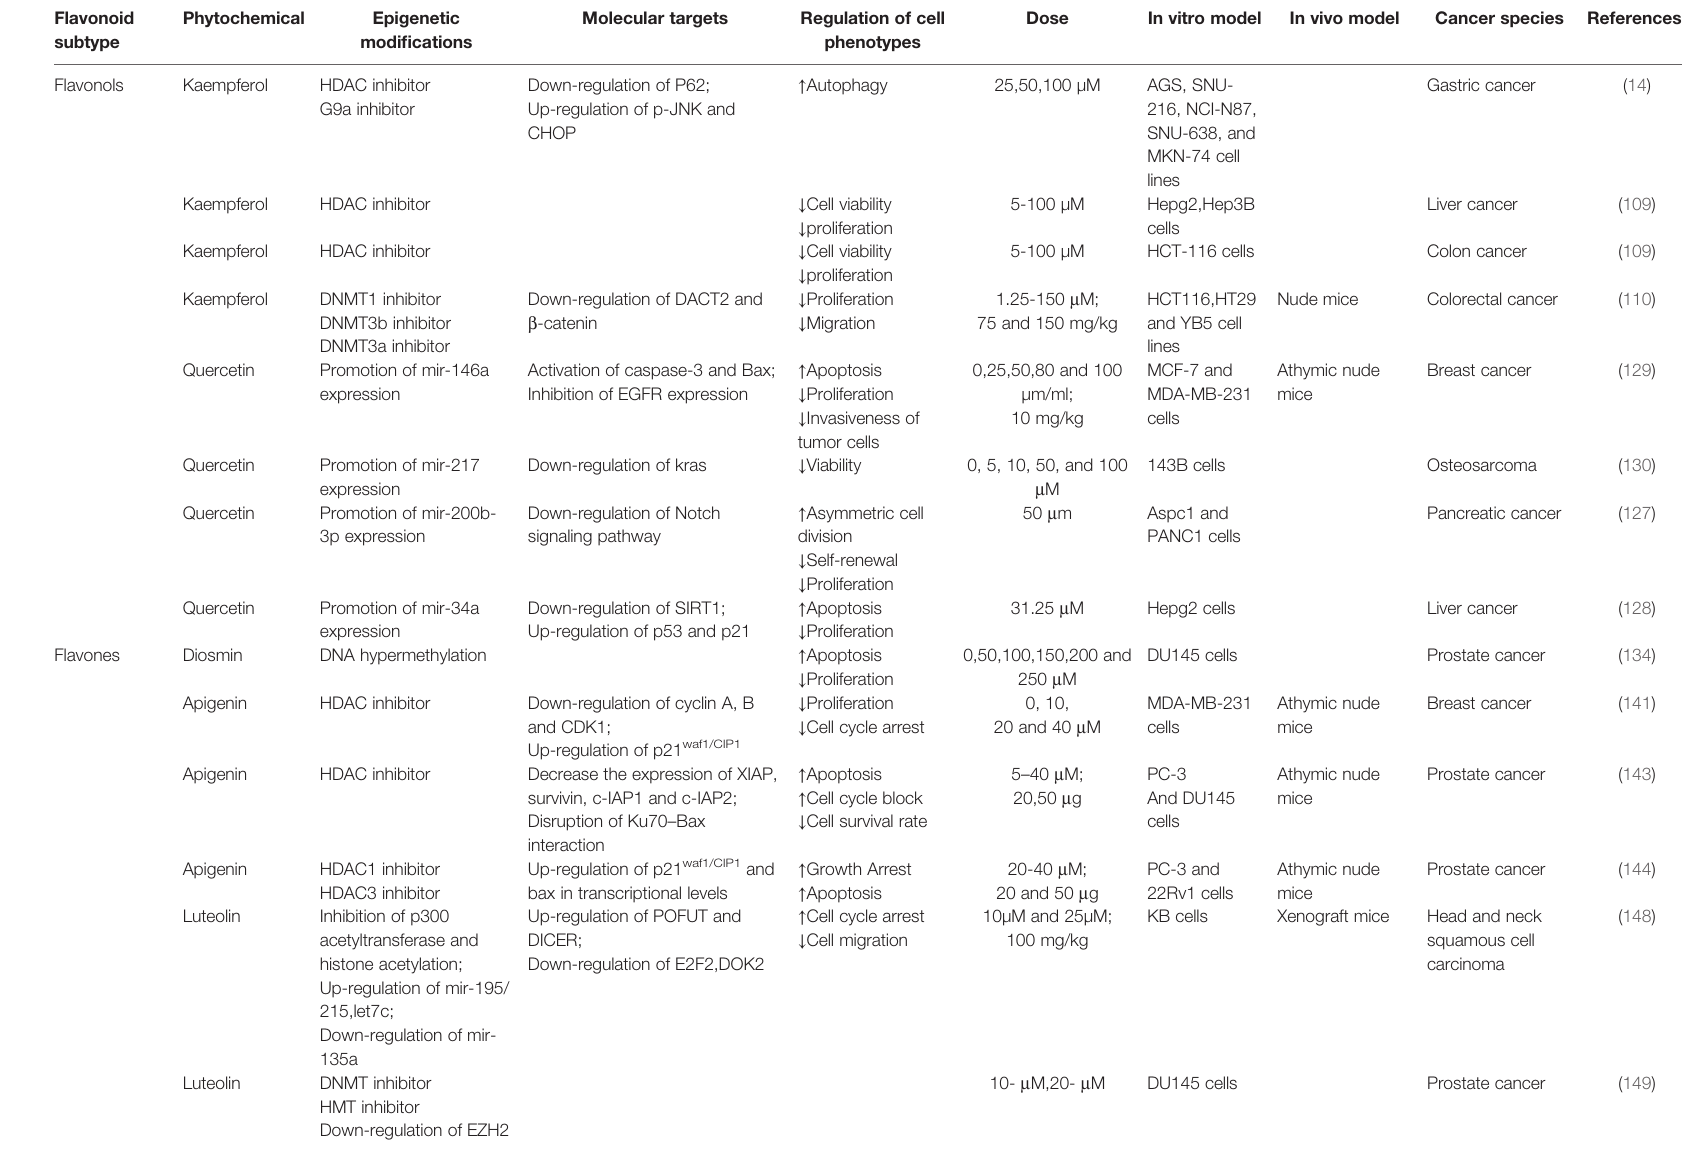
TABLE 2 | Epigenetic effects of fl avonoids on different types of cancers in vitro and in vivo